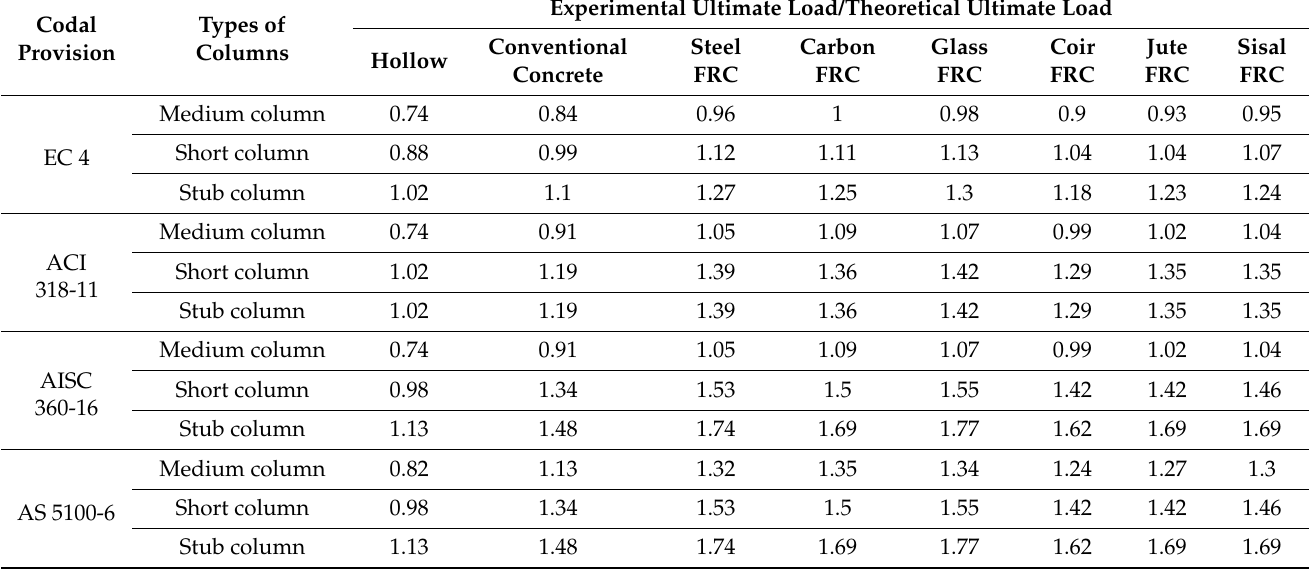
Table 6. Ratio of ultimate experimental load to ultimate theoretical load for various CFST